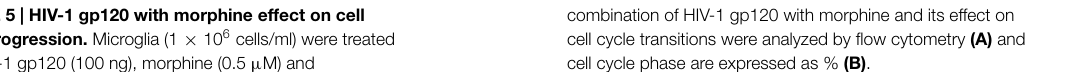
combination of HIV-1 gp120 with morphine and its effect on cell cycle transitions were analyzed by flow cytometry (A) and cell cycle phase are expressed as % (B)